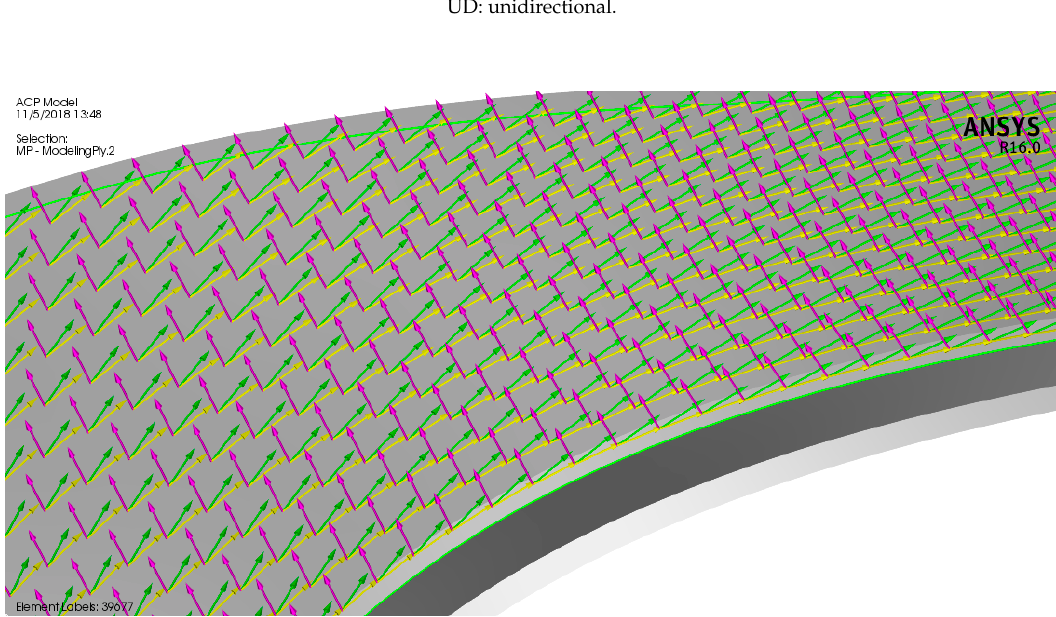
Figure 9. An ANSYS Composite PrepPost (ACP) composite model for the rotor blade with fiber orientations of 20° from the blade edge.